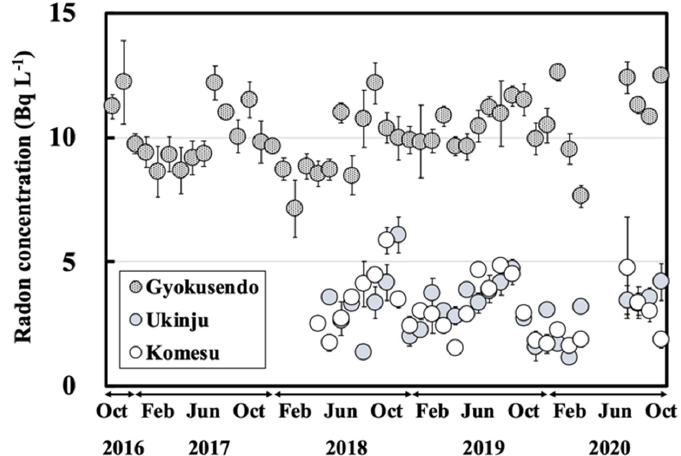
Figure 4. Radon concentration variation for the Gyokusendo cave, Ukinju spring and Komesu spring water samples collected during the October 2016-October 2020 sampling period.